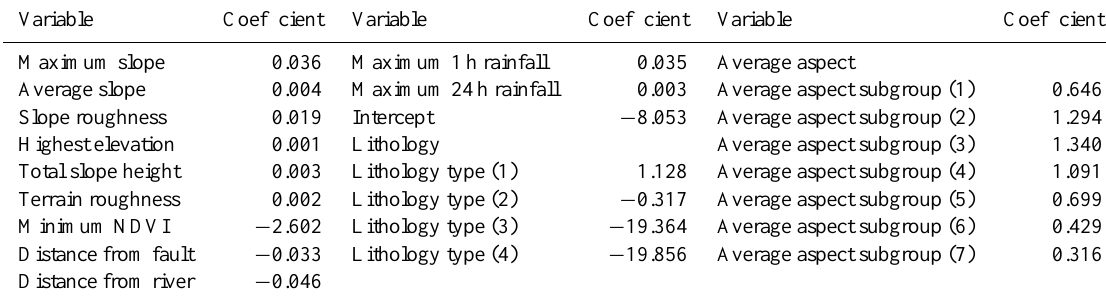
Table 3. Coefficients of variables used in the logistic regression equation.